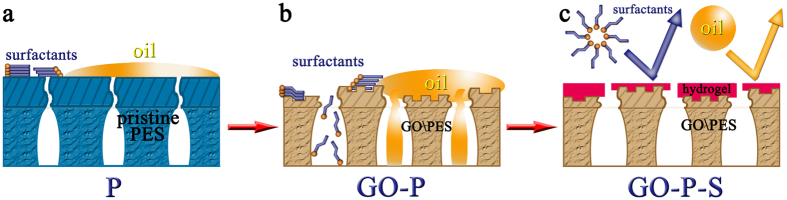
Different working mechanisms among P, GO-P and GO-P-S membranes during nanoemulsion separation process.(a) The hydrophobicity and underwater oleophilicity of P membrane leads to severe fouling induced by both surfactant and oil. (b) The nano-engineering by introducing GO sheet can increase pure water permeability (PWP) of phase inversion constructed membrane through enlarging selective layer pore radius. However, topography roughness of membrane is also increased with membrane surface remained oleophilic under water. As a result, GO-P membrane is poor in both antifouling capability and rejection of surfactant as well as oil. (c) Surface functionalization with hydrogel macromolecule can tune selective layer pore radius small enough to reject surfactant, reduce topography roughness and endow the resultant GO-P-S membrane with high oleophobicity under water. The synergistic effect of smooth topography and underwater oil-repellency leads to the multipotent antifouling capabilities that resist both oil and surfactant induced fouling. Moreover, GO-P-S membrane also achieves high rejections of both surfactant and oil.